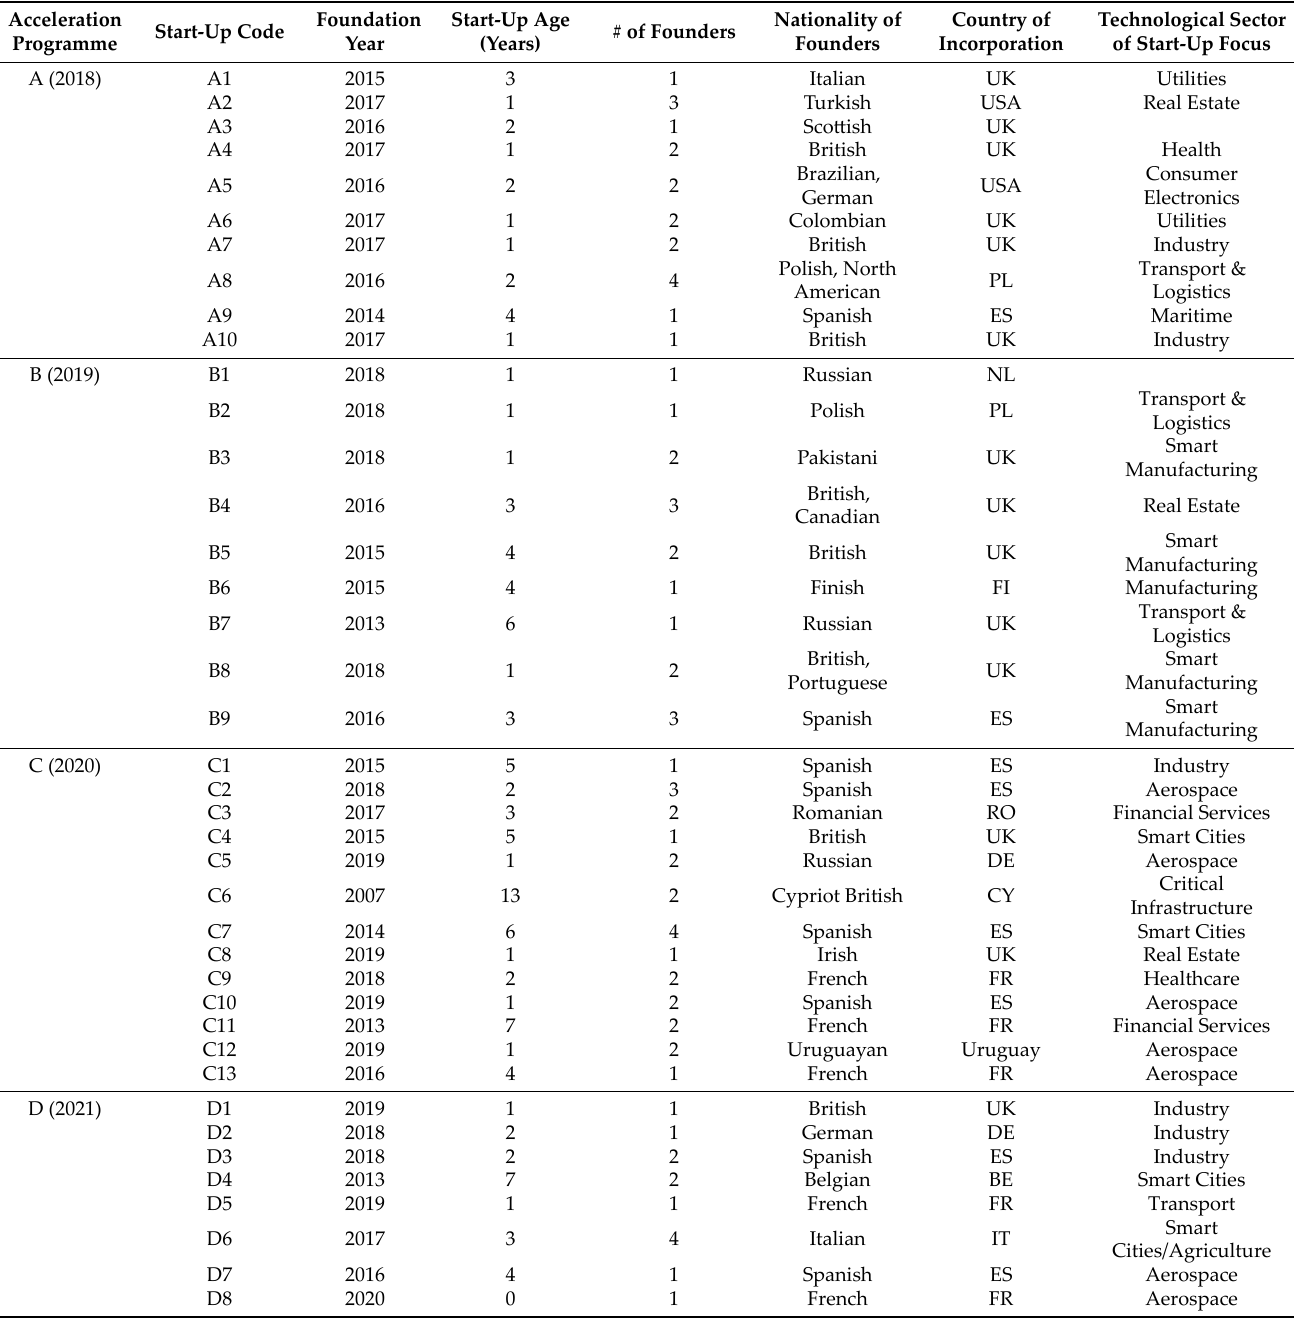
Table A2. Anonymised data of the participating